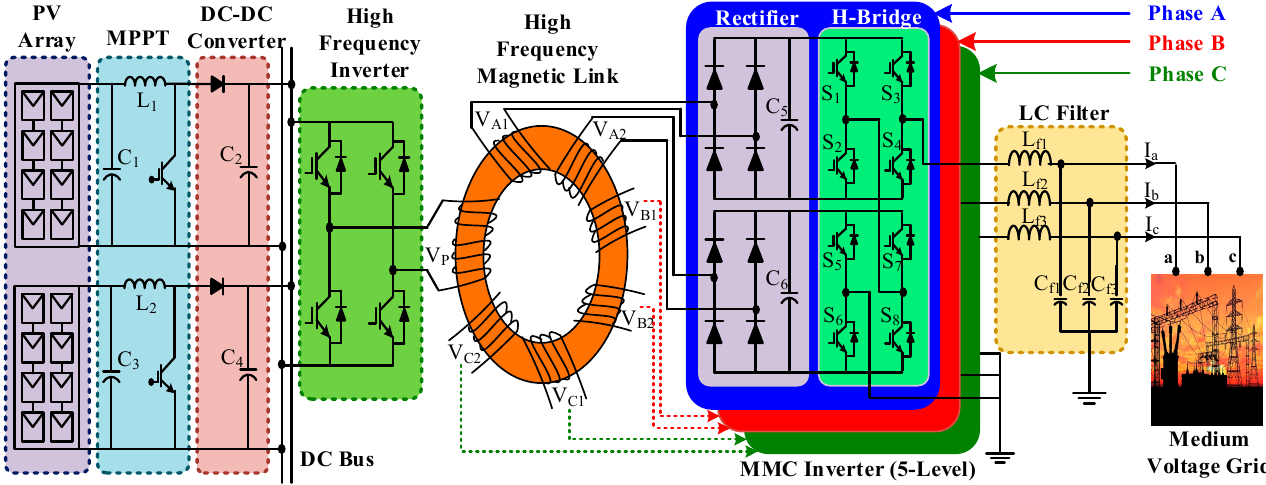
Figure 1. The modular multilevel cascaded (MMC) inverter-based grid-tied photovoltaic (PV) system.